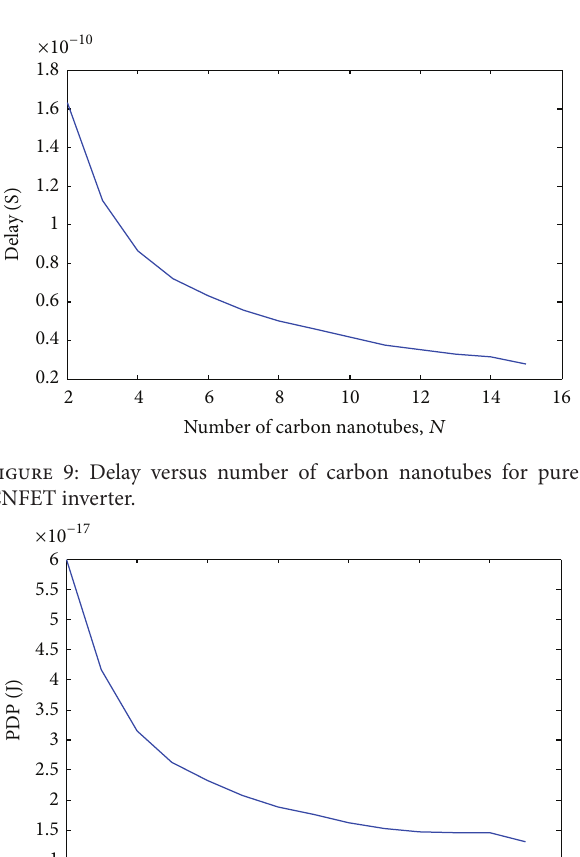
Figure 6: Effect of diameter variations on average delay for pure technology design.